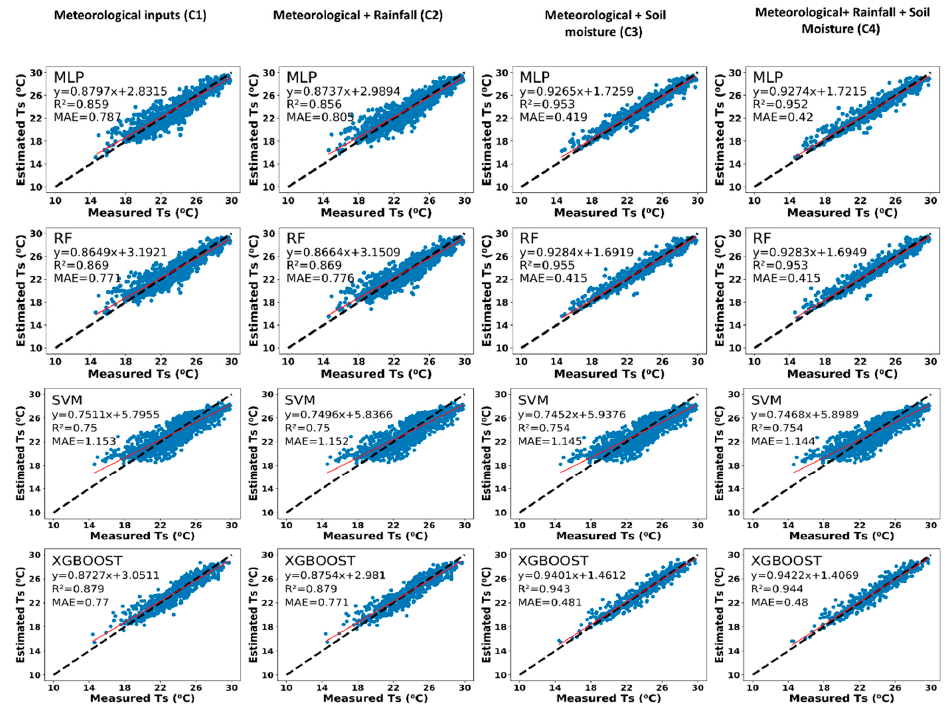
Figure 8. Scatter plots between estimated and measured half-hourly soil temperature (Ts) showing R 2 and mean absolute error (MAE) of 16 different model combinations for grassed hillslope (black dashed line represents 45 degree line and red solid line represents regression line).